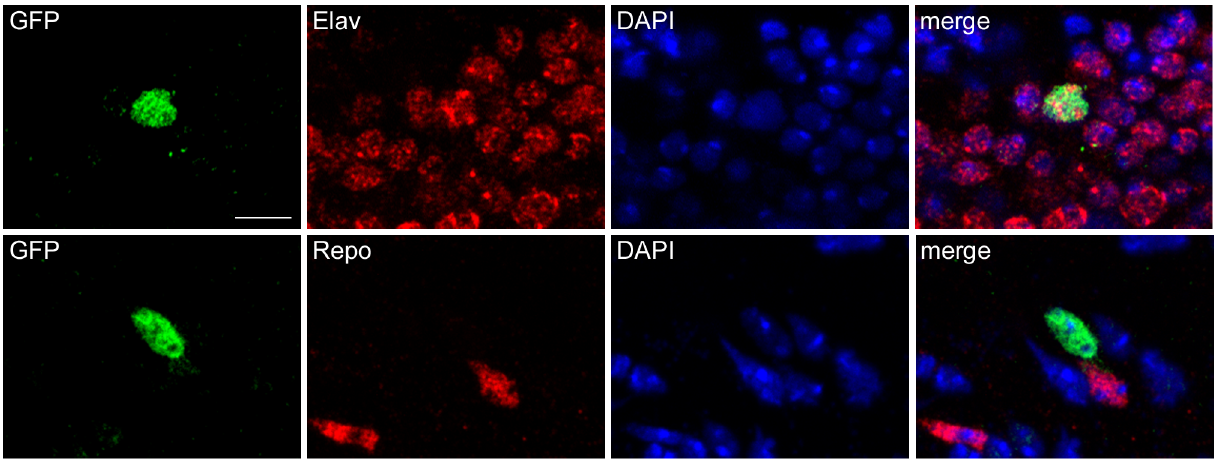
Figure 1. Upregulation of unfolded protein response. Splicing of an Xbp1-EGFP reporter construct in neurons (marked by anti-elav immunostaining, upper panels), but not glia (marked by anti-repo immunostaining, lower panels) in flies expressing tau R40W using the panneural elav- GAL4 driver. Scale bar is 5 m m. Flies are 10 days old.